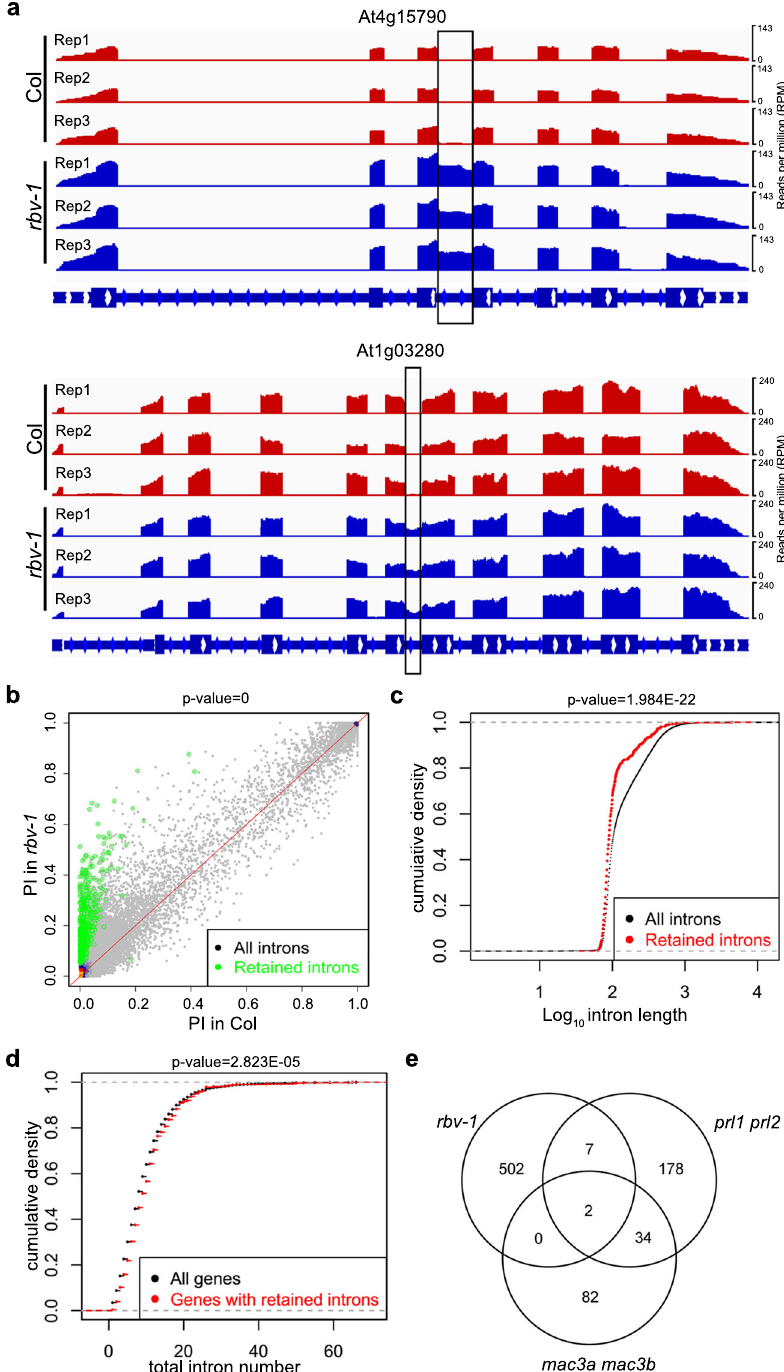
Fig. 6 RBV function is required in the splicing of short introns in certain pre-mRNAs. a Examples of two genes with intron retention defects in the rbv-1 mutant. RNA-seq reads are shown against the gene models below. In the gene models, rectangles and lines represent exons and introns, respectively. The black rectangles indicate retained introns in the rbv-1 mutant. b A scatter plot showing percent retained introns (PI) in wild type and the rbv-1 mutant. The green dots represent introns with statistically signi fi cant retention defects in the mutant (Wilcoxon test, P = 0). c Cumulative density plots of intron length for all introns and for retained introns in the rbv-1 mutant (Wilcoxon test, P = 1.984E − 22). d Cumulative density plots of intron number in all genes and for genes with retained introns in the rbv-1 mutant. (Wilcoxon test, P = 2.823E − 05). e Venn diagrams showing the numbers of retained introns in rbv-1 , prl1 prl2 and mac3a mac3b mutants, and the overlaps among the introns retained in these mutants.